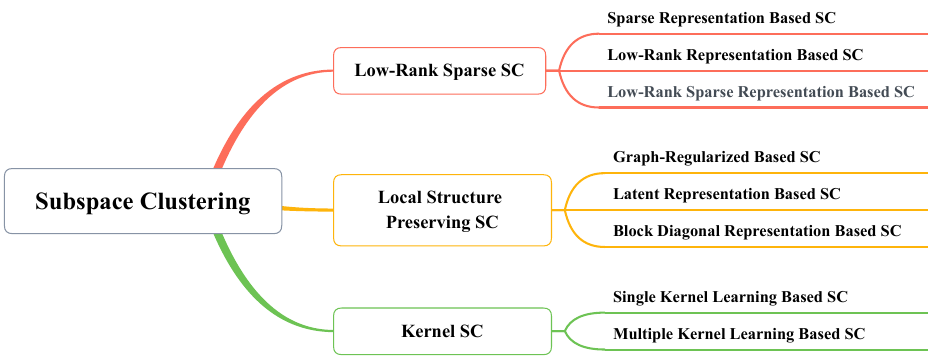
Figure 4. The categories of SC methods.